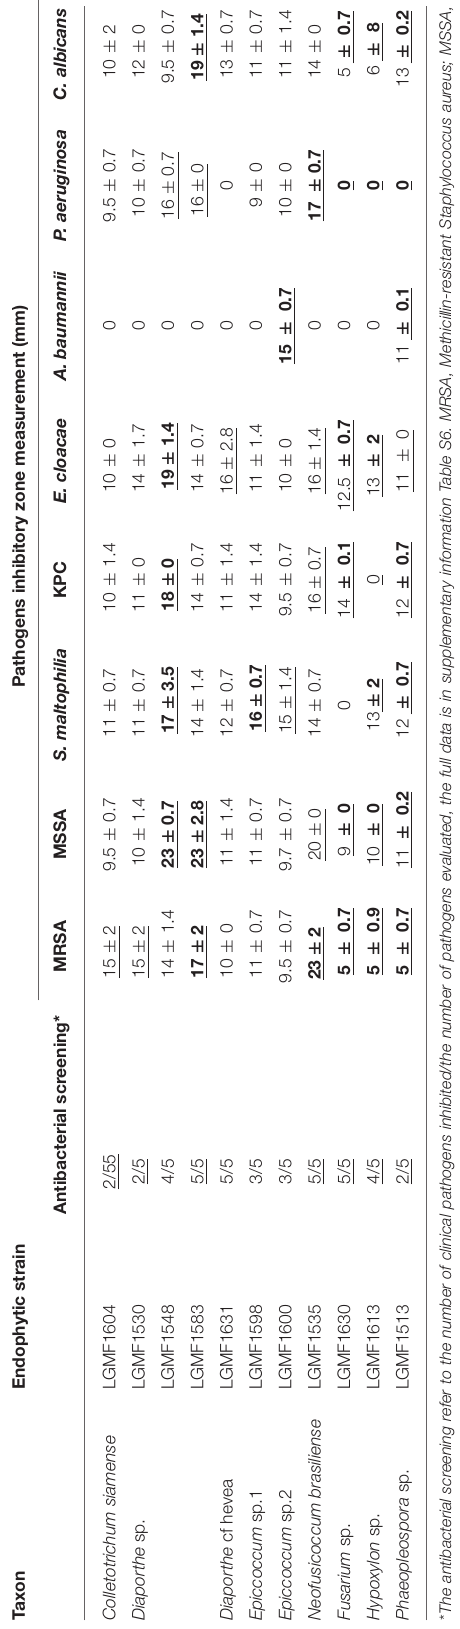
( Figure 4 ; Tables S4, S5). The main difference in the community structure comes from a higher abundance and richness of endophytes in petioles, which may be result of a specialized endophytic microbiota (Persoh, 2015; Correia et al., 2017). Diaporthe was the dominant genus in both plants ( Figure 3 ; Table S1). This genus has also been described as dominant in S. adstringens by Carvalho et al. (2012) and is widely distributed in different plants of several biomes, such as the Pantanal (Hokama et al., 2017; Pietro-Souza et al., 2017), Mangrove forest (de Souza Sebastianes et al., 2013), Atlantic Rainforest (Correia et al., 2017), Cerrado and Caatinga (Ferreira et al., 2012; Lisboa et al., 2013). The ability of Diaporthe species to colonize different plants may result from the produced metabolites that bypass the plants defenses, or even by acting on host development and defense against plant pathogens (Nicoletti and Fiorentino, 2015; Santos et al., 2016; Tahir et al., 2017). Associated with the high frequency of isolation, we also found new species of Diaporthe , named as Diaporthe sp.1 (clade 1), Diaporthe sp. 2 (clade 2), (Figure S11). Gomes et al. (2013) also reported a large